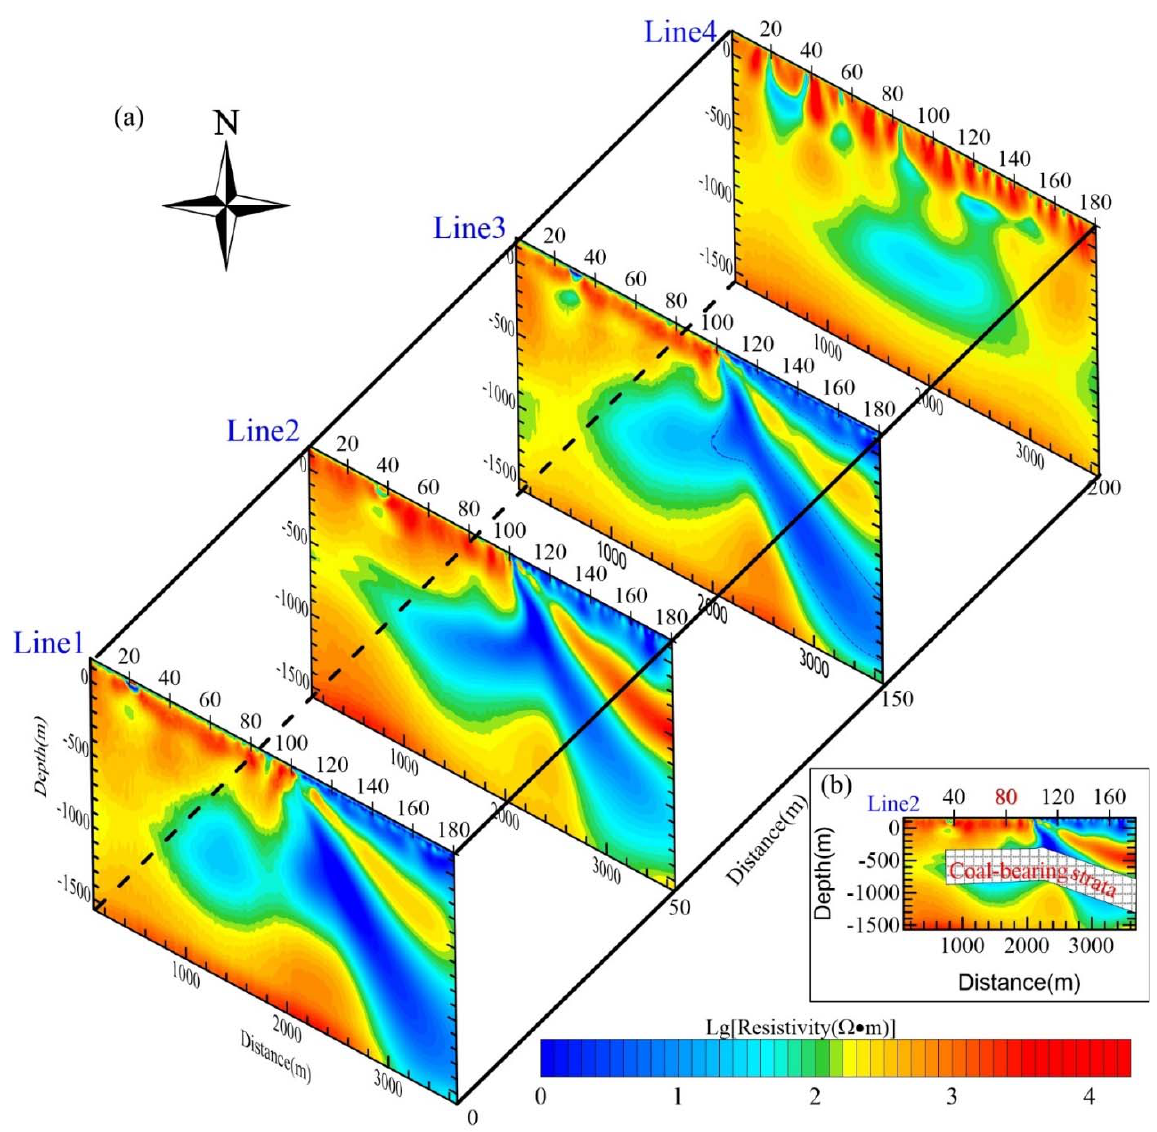
Figure 5. ( a ) Inverted section of CSAMT survey. ( b ) Inferred coal-bearing strata and designed drilling location (80th Station on Line 2). Obviously, the coal-bearing strata near the core of syncline structure are deeply buried. In order to save on drilling costs, we designed the drilling at the 80th Station on Line 2, where the depth of coal-bearing strata is relatively shallow (~600 m).